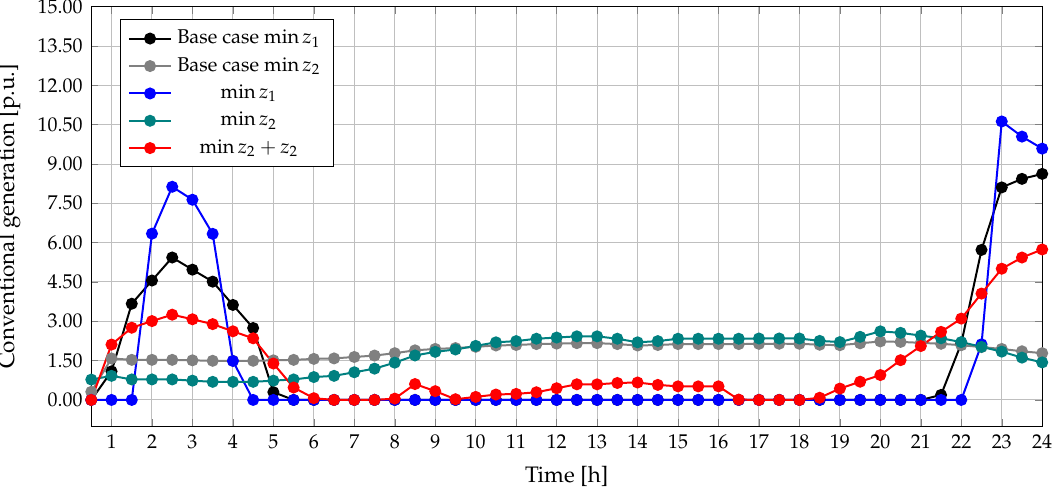
Figure 9. Behavior of the conventional generation (e.g., slack node) for all the cases